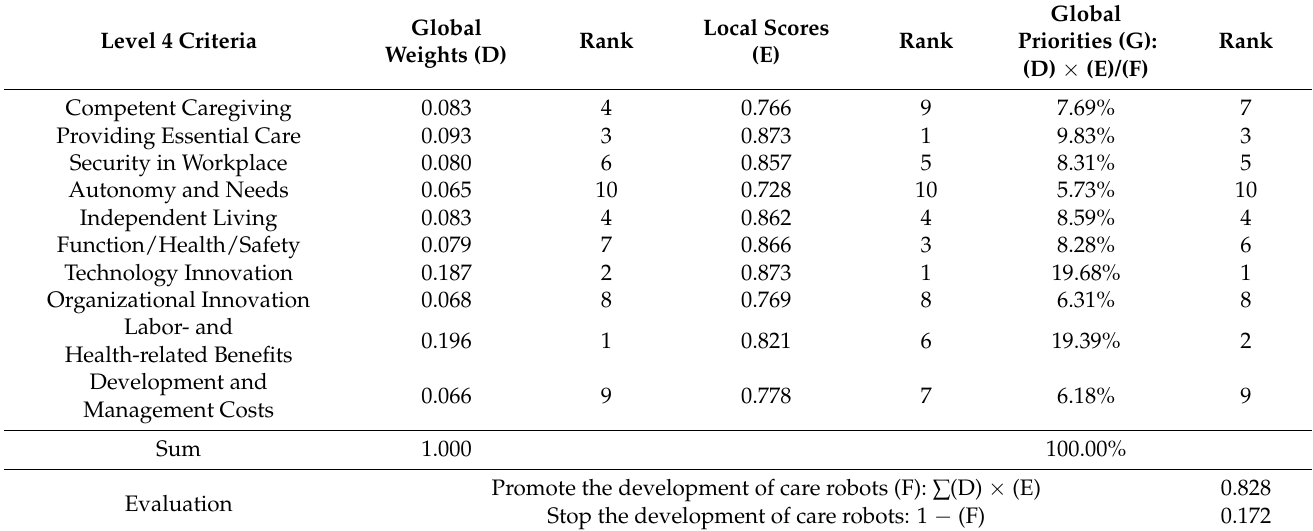
Table 4. Evaluation of alternatives and priorities of social values of care